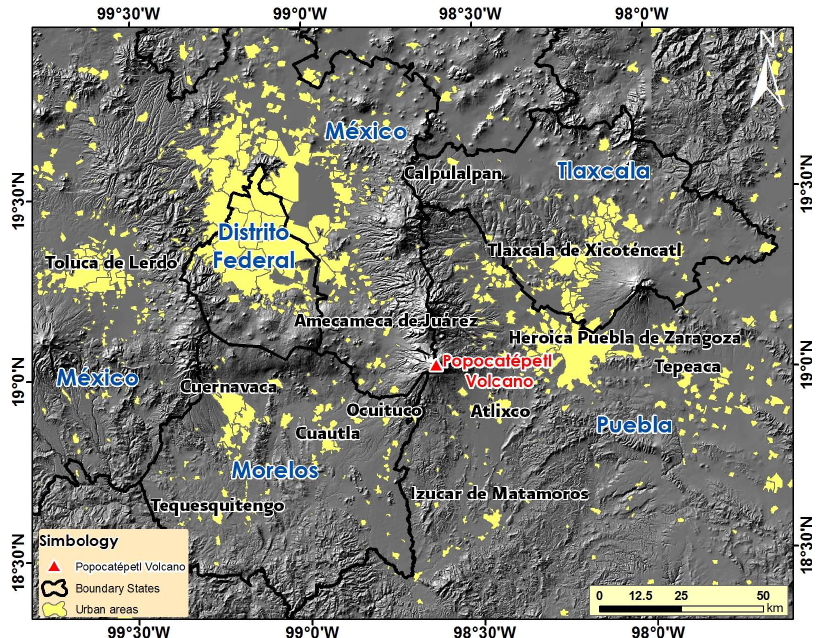
Fig. 1. Map of Popocat´epetl volcano and its densely populated surroundings. Urban settlements within a radius of 100km around Popocat´epetl volcano (shown in yellow) may exceed